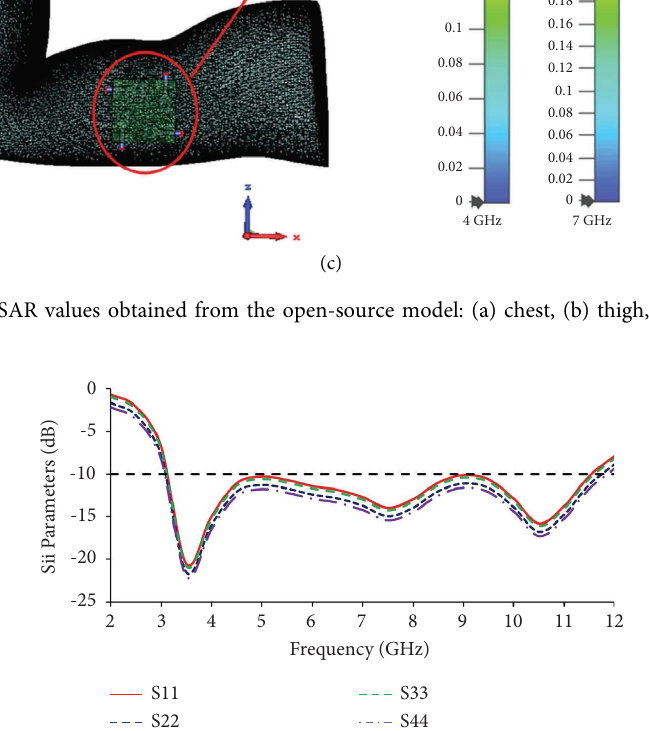
Figure 21: Simulated refection coefcient plot for on-body analysis of the MIMO antenna.